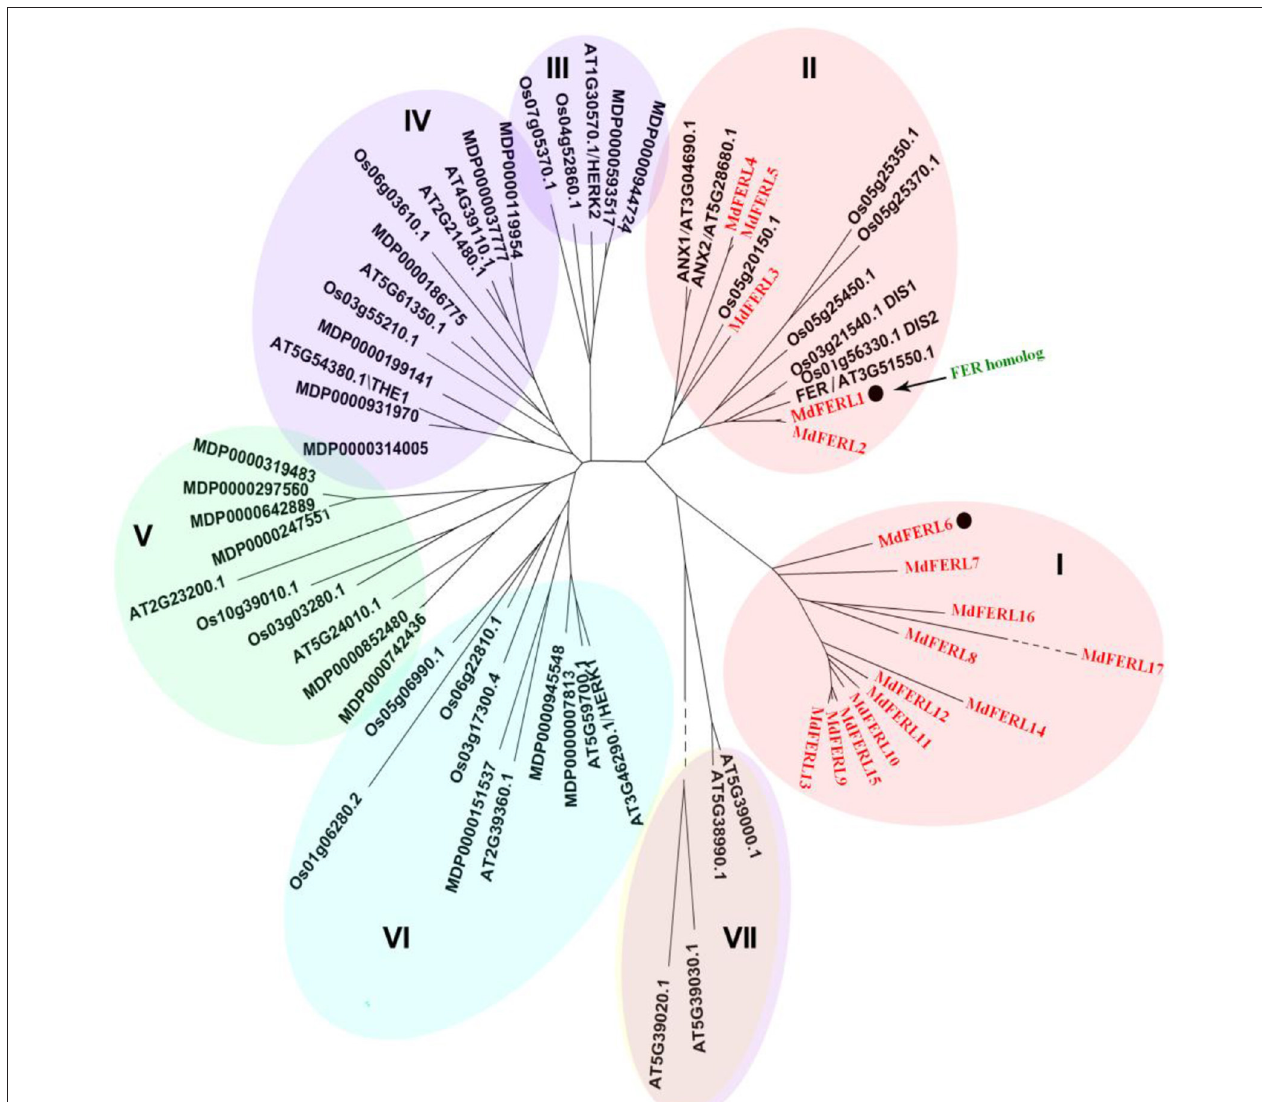
FIGURE 1 | Phylogenetic tree of deduced CrRLK1L amino acid sequences. Phylogenetic analysis of CrRLK1L homologs from various plant species. The phylogenetic tree was constructed using the Neighbor-Joining method in MEGA4.0.2 using 1,000 bootstrap replicates. The numbers at nodes represent bootstrap values. Species name abbreviations are as follows: Md, Malus × domestica ; At, Arabidopsis thaliana ; Os, Oryza sativa .